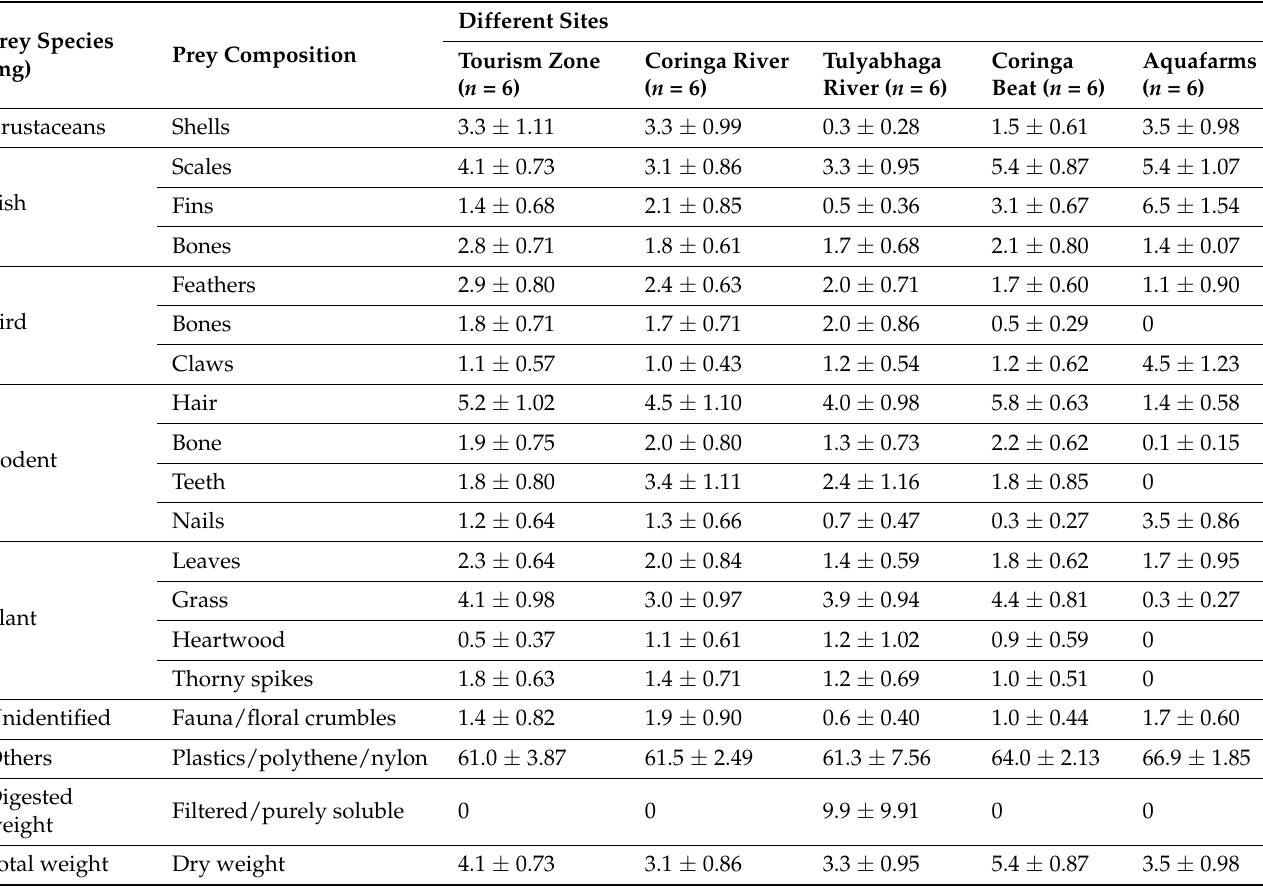
Table 1. Prey species and their composition found in the scats of fishing cat, Coringa Wildlife Sanctuary, Andhra Pradesh, India from March to June 2022 (values are mean and SE; n =